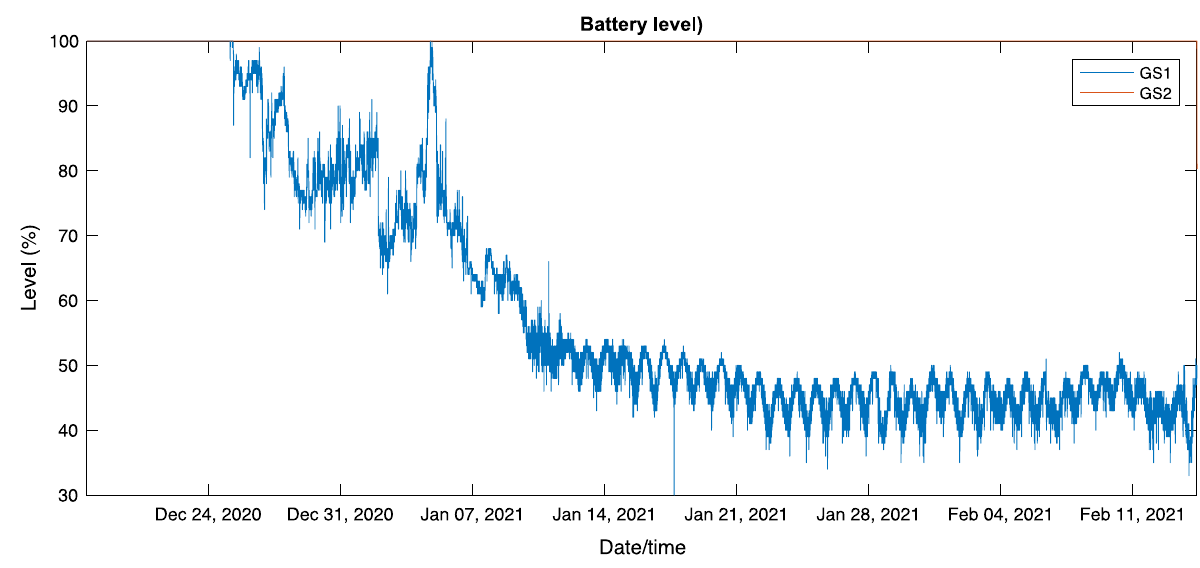
Fig. 12 Battery levels are reported by both gas monitoring stations. Note how GS2 reports constant battery level of 100% while GS1 start degrading around December 25th despite receiving more optical power that